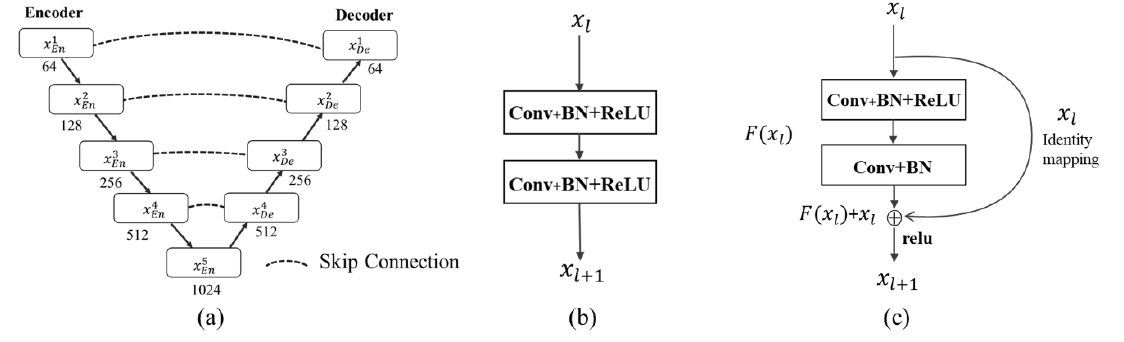
Figure 1. ( a ) The structure of the U-Net model; ( b ) Plain neural unit in U-Net; ( c ) Residual